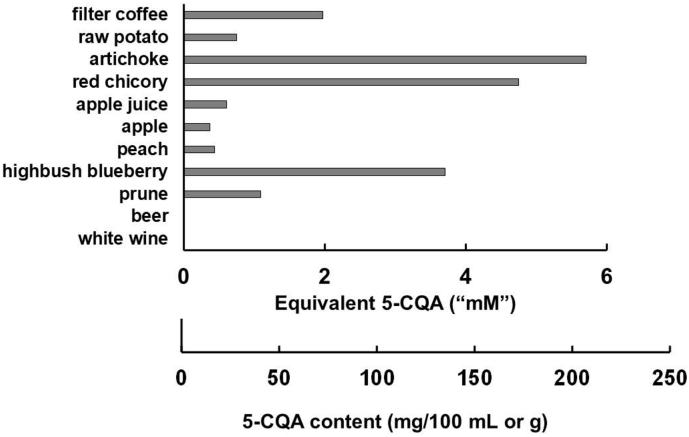
Content of 5-caffeoylquinic acid in various foods and beverages. Data is obtained from phenol-explorer (Neveu et al., 2010), as mg per 100 mL or 100 g. For ease of assessment, the value has been converted into apparent "mM" based on the content. This is close to the correct value for beverages, but for foods would depend on chewing, extraction and other parameters, and is given as a guide only.